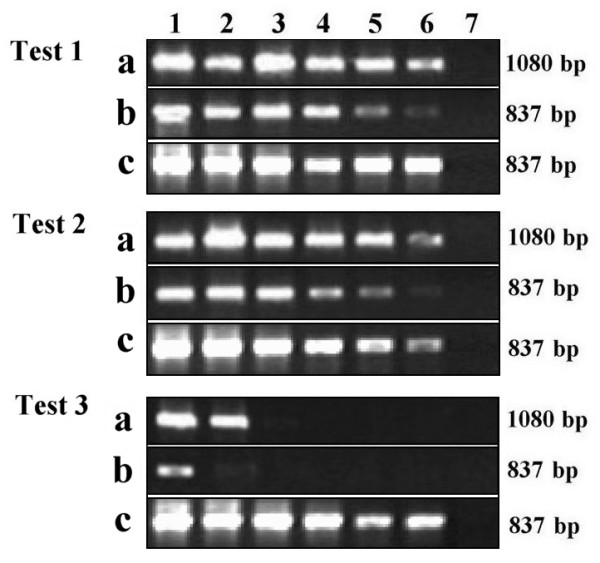
Comparison of the detection sensitivity between different nested PCR setups. Test 1, G. abietina; Test 2, G. abietina mixed with P. contorta; Test 3, G. abietina mixed with seven other fungi, in amplifications with NS1/8-NS.Grem3/4 (a), NS1/8-NS.Grem5/6 (b) and NS.Grem3/4-NS.Grem5/6 (c). See Table 3 for DNA contents in each lane.